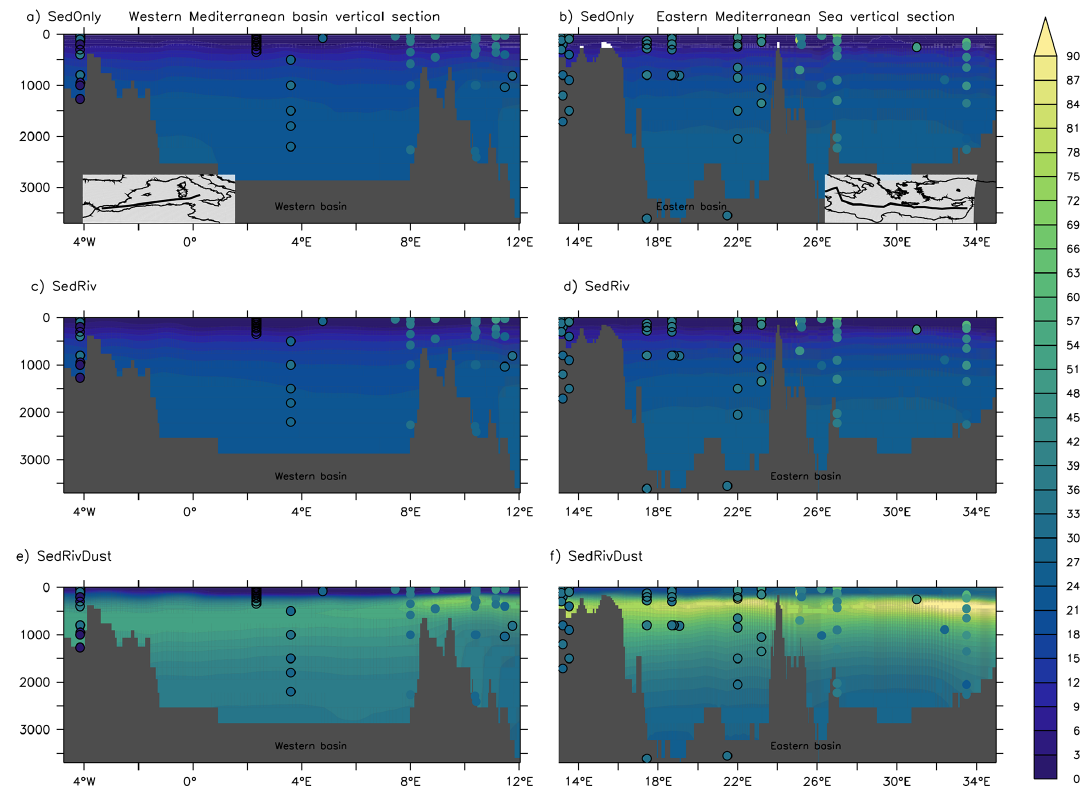
Figure 4. E–W vertical section of [Nd] (in pmolkg − 1 ) in the western Mediterranean basin from SedOnly (a) , SedRiv (c) , and SedRivDust (e) . E–W vertical section of [Nd] (in pmolkg − 1 ) in the western Mediterranean basin from SedOnly (b) , SedRiv (d) , and SedRivDust (f) ; colour- filled dots represent in situ observations from Tachikawa et al. (2004); Vance et al. (2004); Henry et al. (1994); Dubois-Dauphin et al. (2017); Garcia-Solsona and Jeandel (2020); Montagna et al. (2022). Both model and in situ data use the same colour